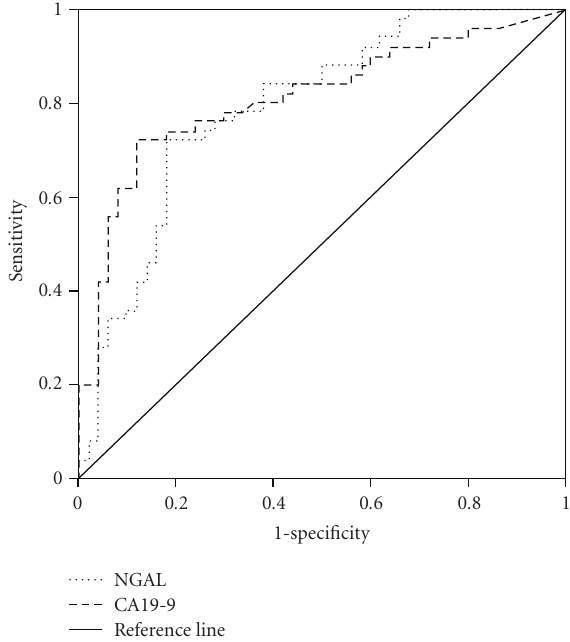
Figure 2: ROC curve analyses of NGAL and CA19-9 for the diagnosis of cholangiocarcinoma . The diagnostic accuracy of each biomarker, in terms of its sensitivity and specificity, is presented by receiver operating characteristic (ROC) curve